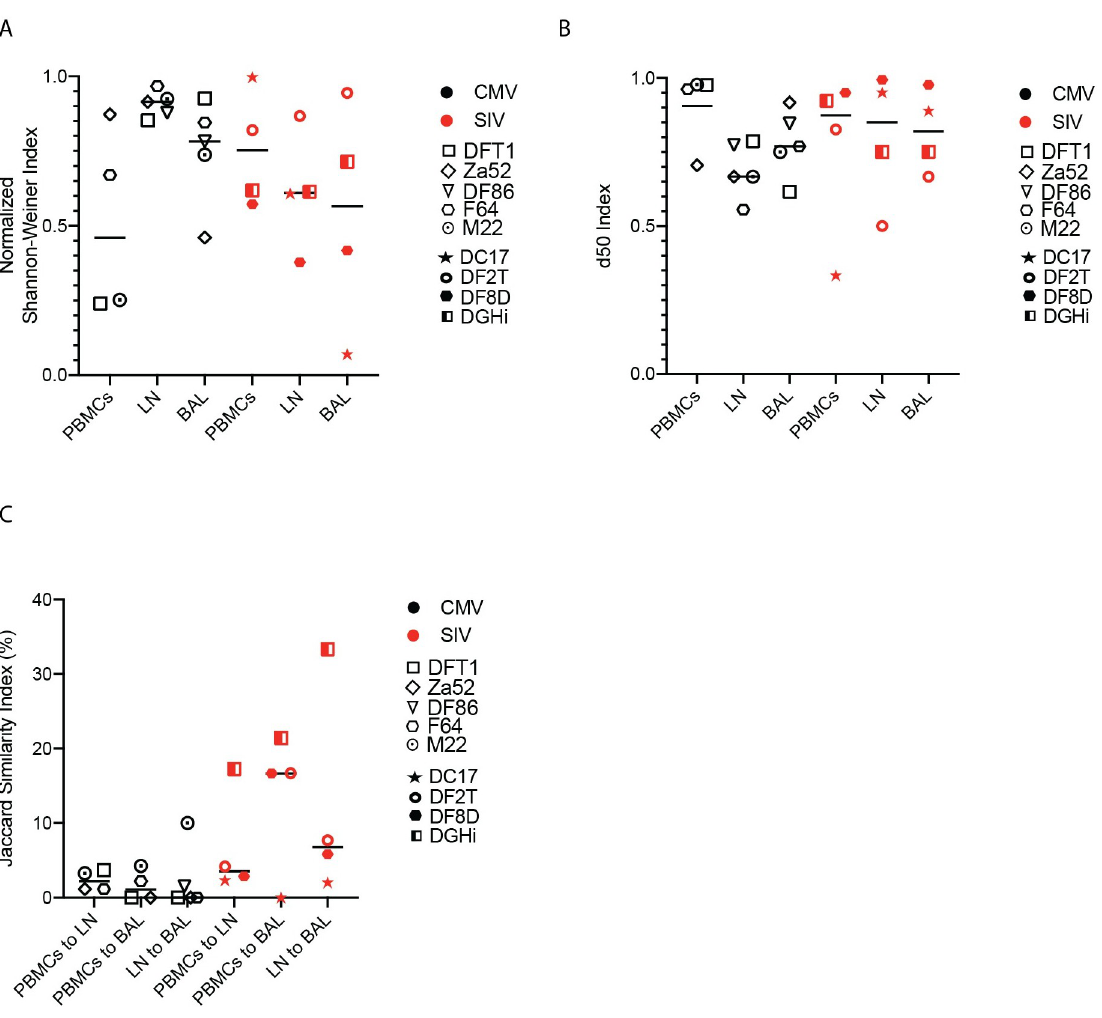
Fig 5. The TCR repertoires of SIV- and CMV- specific CD8 + T cells exhibit similar diversity and tissue similarity. PBMCs, LN and BAL were sampled from rhesus macaques who were chronically infected with SIVmac239X (without ARV treatment) or naturally infected with CMV. (A) The normalized Shannon-Weiner diversity index of the TCR repertoires. (B) The d50 diversity index of the TCR repertoires. (C) The Jaccard similarity index for comparisons between each tissue’s TCR repertoire. Data are presented as mean, with individual data points. One way ANOVA was used to determine statistical significance. n = 3 to 6